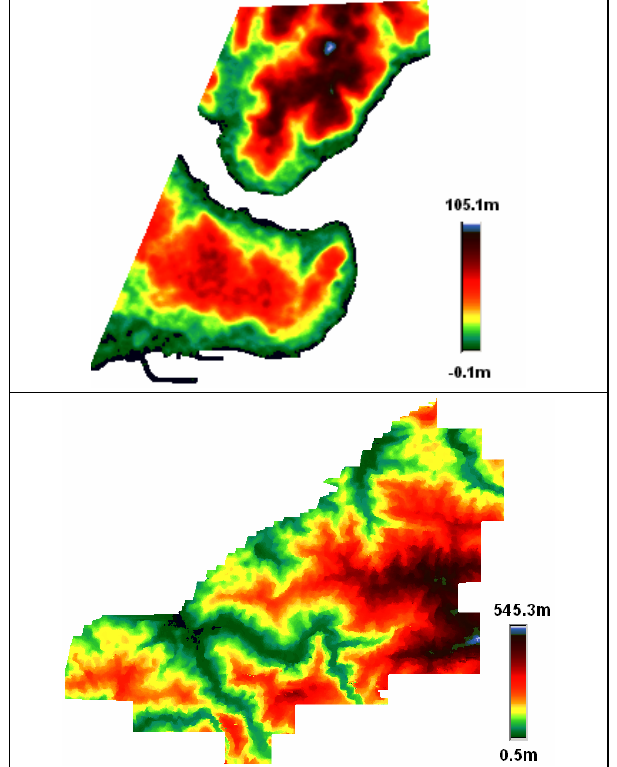
Figure 4. Color coded SPOT-5 HRS height models